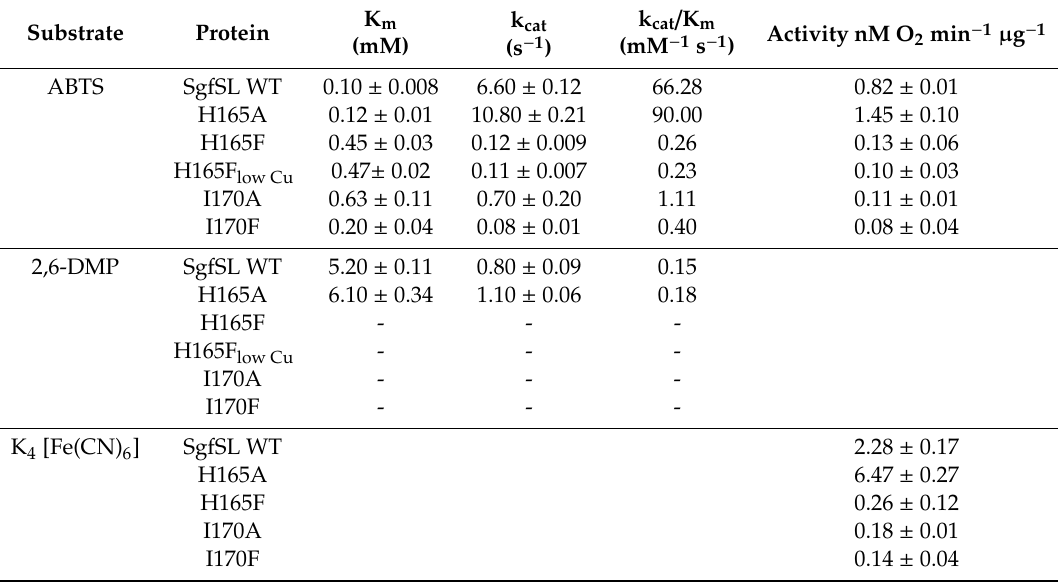
Table 3. Kinetic parameters of the SgfSL